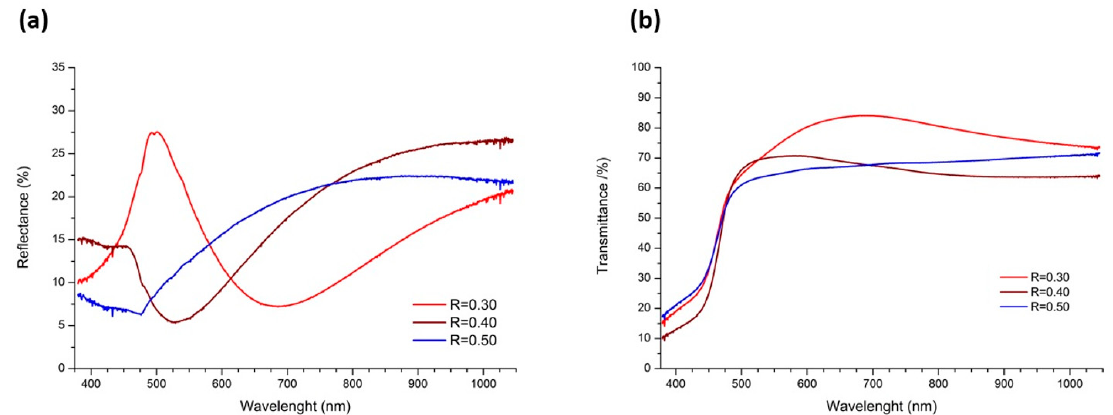
Figure 4. ( a ) Re fl ectance spectra and ( b ) transmi tt ance spectra of Raman spectra of CdS:Al thin fi